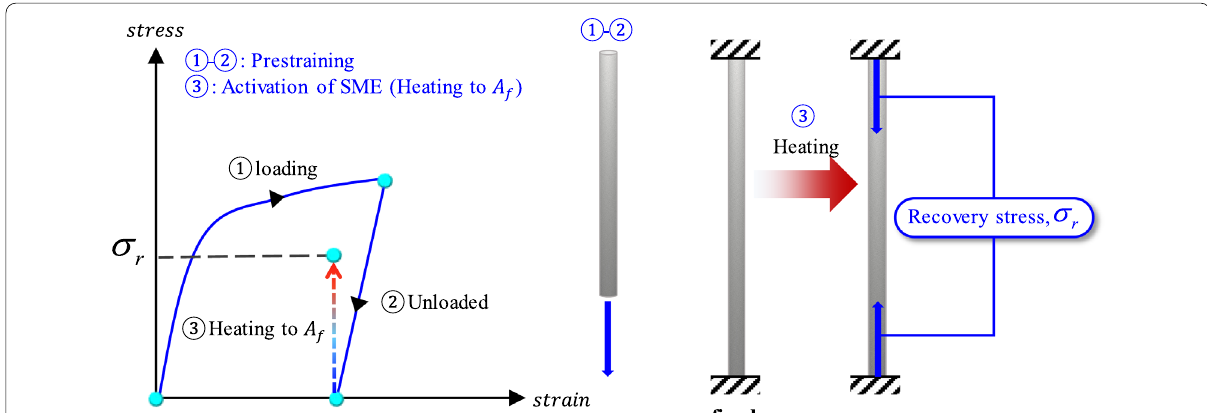
Fig. 2 Mechanical and thermomechanical behavior of typical